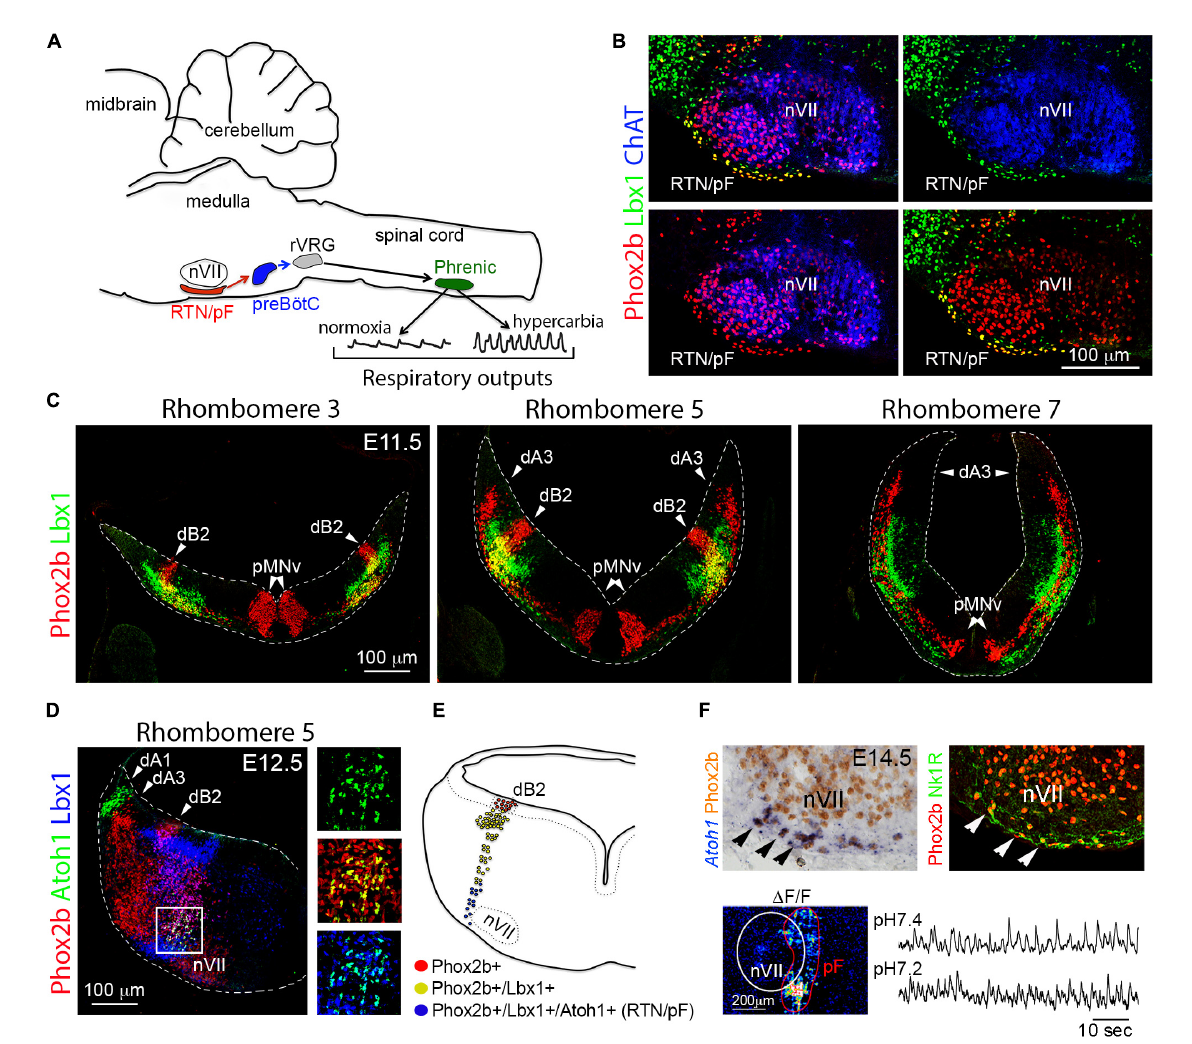
FIGURE6 Development of the retrotrapezoid/parafacial nucleus. (A) Schema representing the location and function of retrotrapezoid/parafacial nucleus (RTN/pF) in mice. Under normal levels of oxygen (normoxia), the activity of the preBötzinger complex (preBötC) controls the firing rate of neurons in the phrenic motor nucleus (Phrenic) by sending signals via premotor neurons located in the rostral ventral respiratory group (rVRG). Phrenic motor neurons control diaphragm activity. Under hypercarbia (high levels of PCO 2 ) RTN/pF neurons increase their firing rate: this adjusts the activity of preBötzinger complex and eventually the firing rate of the phrenic motor neurons, which in turn increases respiration (B) Histological characterization of RTN/pF in newborn mice (P0). RTN/pF neurons co-express Phox2b and Lbx1 but not choline-acetyltransferase (ChAT), which distinguishes them from facial motor neurons (nVII) that express Phox2b and ChAT but not Lbx1. (C) Histological characterization of dB2 neurons across the indicated rhombomeres (r). dB2 neurons co-express Phox2b and Lbx1 at E11.5 in mice. This molecular signature distinguishes them from the dorsal (dA3 neurons) and ventral (pMNv) cells that express Phox2b but not Lbx1. Note that dB2 neurons emerge from r2 to r6, whereas dA3 neurons originate in r4 to r7/8 and pMNv cells can be found from r2-r7/8 (see text). (D) Transverse section of a E12.5 mouse embryo stained with antibodies against Phox2b, Atoh1, and Lbx1. Note that a subset of dB2 neurons (magenta cells) activate the expression of Atoh1 as they reach the facial (nVII) motor nucleus (boxed area). The boxed area is illustrated at the right with different combinations of the fluorescent signals. (E) Schema depicting the development of RTN/pF neurons. Phox2b + dB2 progenitor cells differentiate an initiate the expression of Lbx1 in neurons. A subset of Phox2b + /Lbx1 + (dB2) neurons ventrally migrates and activates the expression of Atoh1 as they reach the facial (nVII) motor nucleus. It is the co-expression of Phox2b + /Lbx1 + /Atoh1 + what defines the molecular signature of RTN/pF neurons. (F) Upper panels, by E14.5 in mice, RTN/pF neurons (arrowheads) settle underneath the facial motor (nVII) nucleus and express additional marker, such as neurokinin 1 receptor (Nk1R). Lower panels, ventral hindbrain view of a E14.5 wholemount brainstem preparation centered on the facial (nVII) motor nucleus showing Ca2 + green-1AM fluorescence changes ( (cid:49) F/F) of parifacial nucleus (pF) activity in physiological (7.4) and low (7.2) pH. This figure is adapted from our previous publication Isik and Hernandez-Miranda (2022) in Handbook of Clinical Neurology, Chapter 5, entitled Early development of the breathing network, published